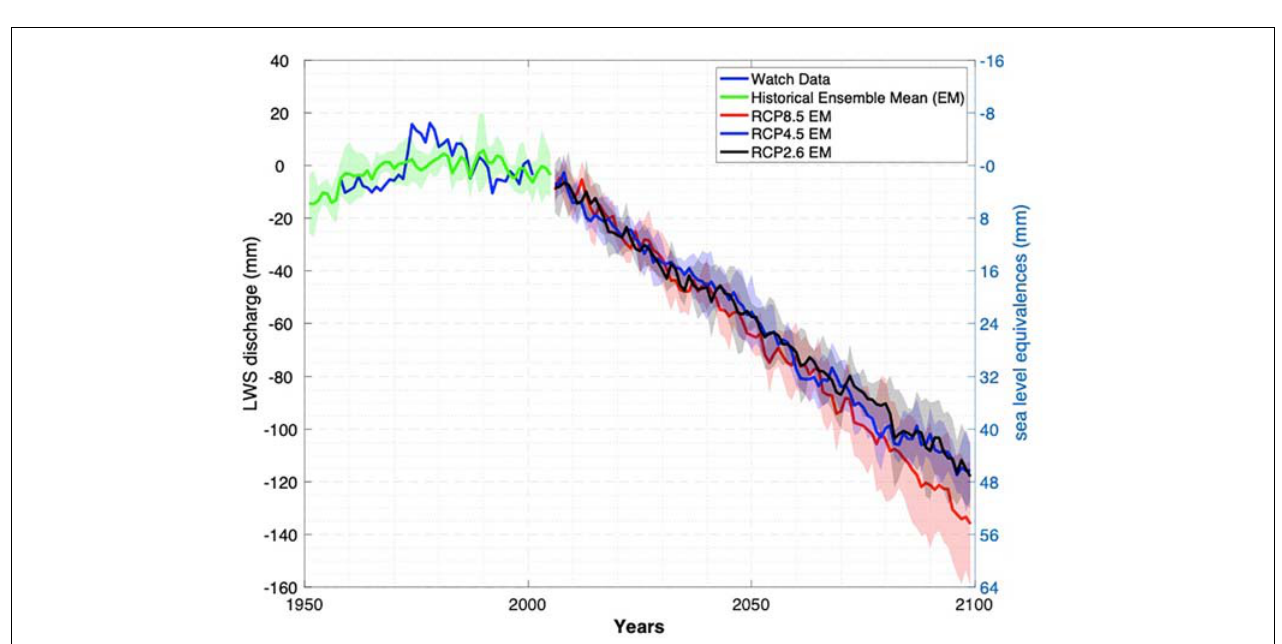
FIGURE 2 | Change in global mean of LWS anomalies over the period 1958–2001 for which observed climate data (Watch) are available and projections with GCM-forcing over the period 1951–2099. Climate models are forced by three different RCP scenarios (RCP8.5, RCP4.5, RCP2.6) for the period 2006–2099. The mean value of observational data over the reference period 1960–1999 is subtracted from both observational data and model output. Shaded areas in scenario ensemble represent ± 1 std. from five models. Note that negative LWS change causes sea-level